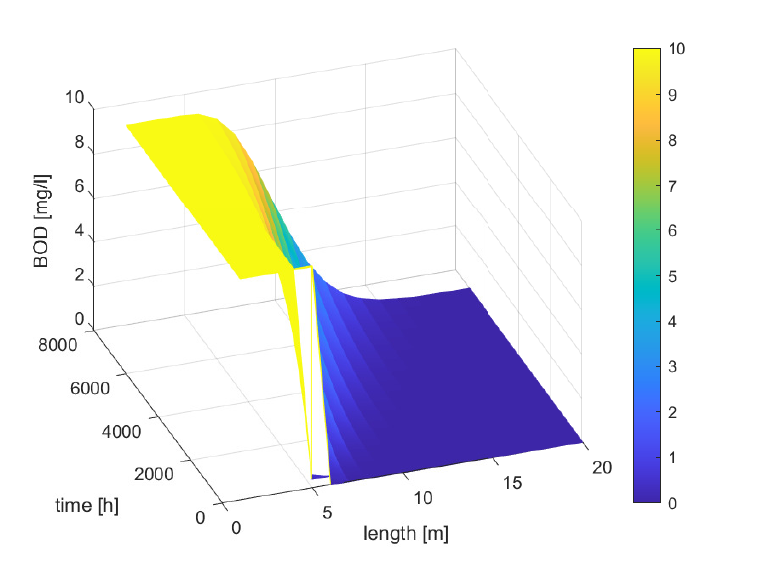
Figure 17. BOD distribution excluding diffusion and no self-cleaning process for V = 0.001.